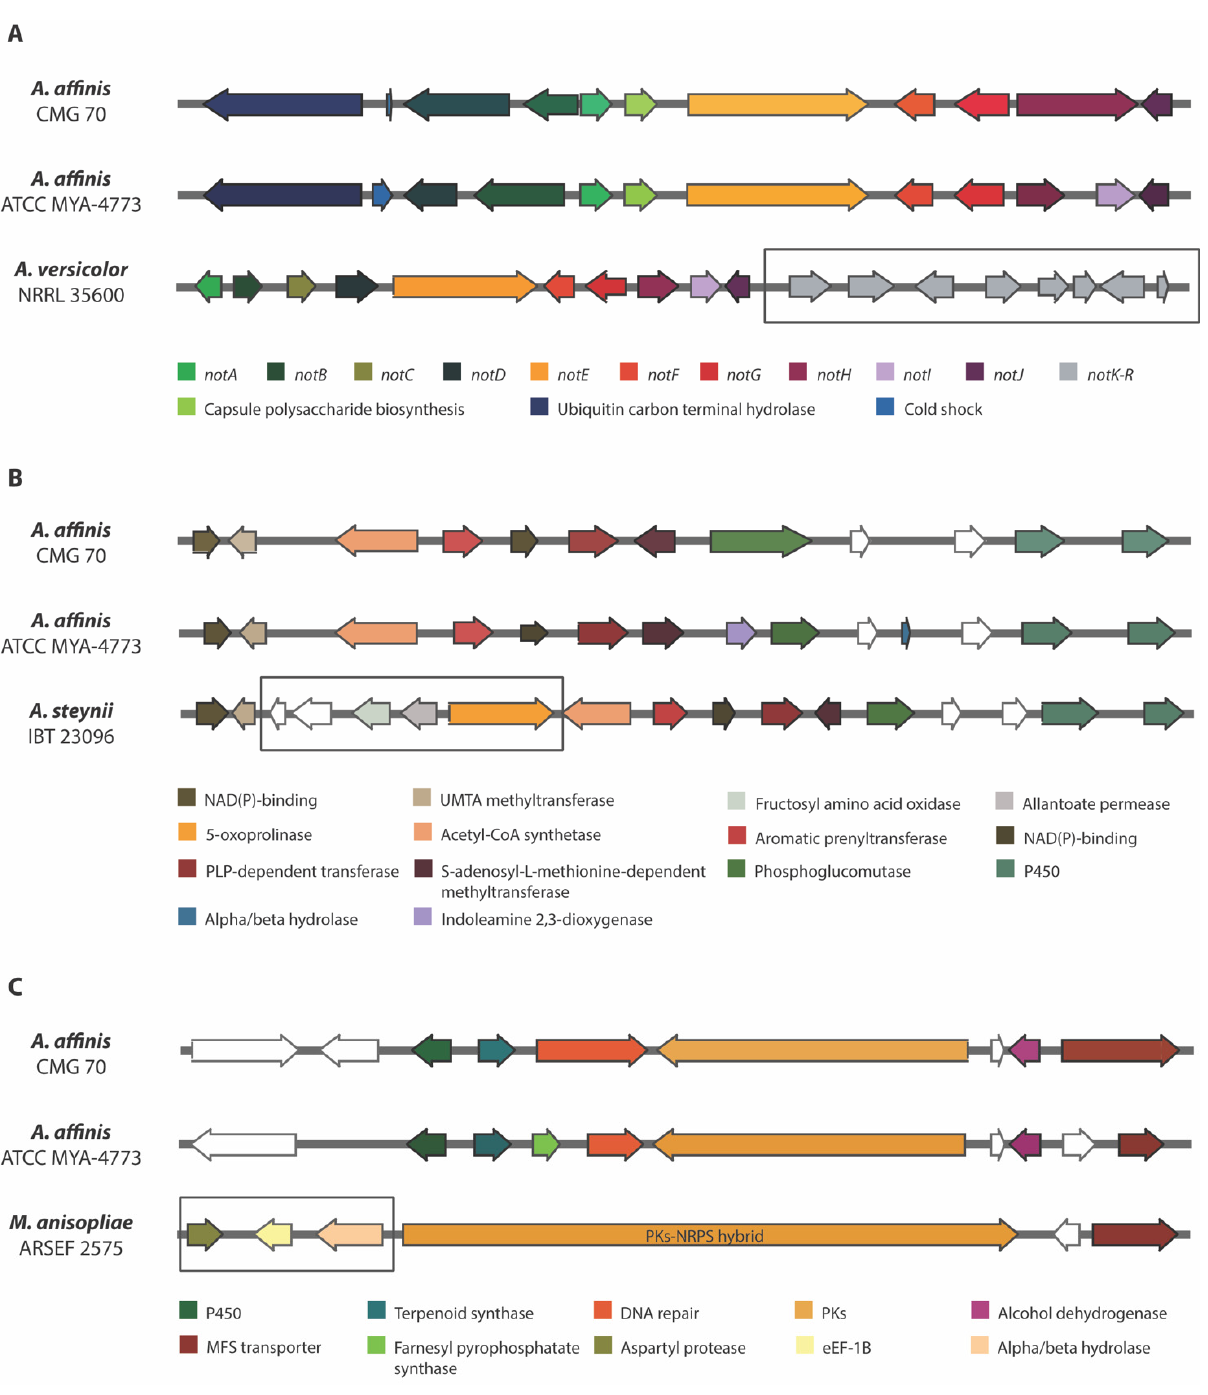
Figure 5. Comparison of three biosynthetic gene regions in Aspergillus affinis strains CMG 70 and ATCC MYA-4773 T with: ( A ) Notoamide BGC of Aspergillus versicolor NRRL 35600; ( B ) Ochrindole A BGC of Aspergillus steynii IBT 23096; and ( C ) NG-391 BGC of Metarhizium anisopliae ARSEF 2575. The genes encoding hypothetical proteins are represented as white arrows. The square box shows the missing genes in relation to the A. affinis cluster.